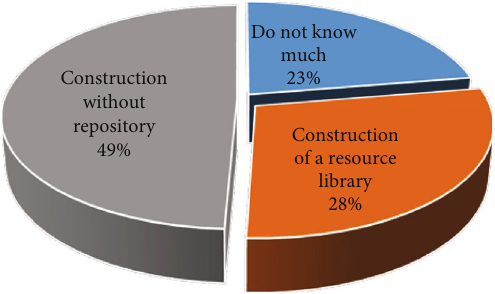
Figure 5: Respondents ’ comprehension of the structure of the school ’ s thought-political resource